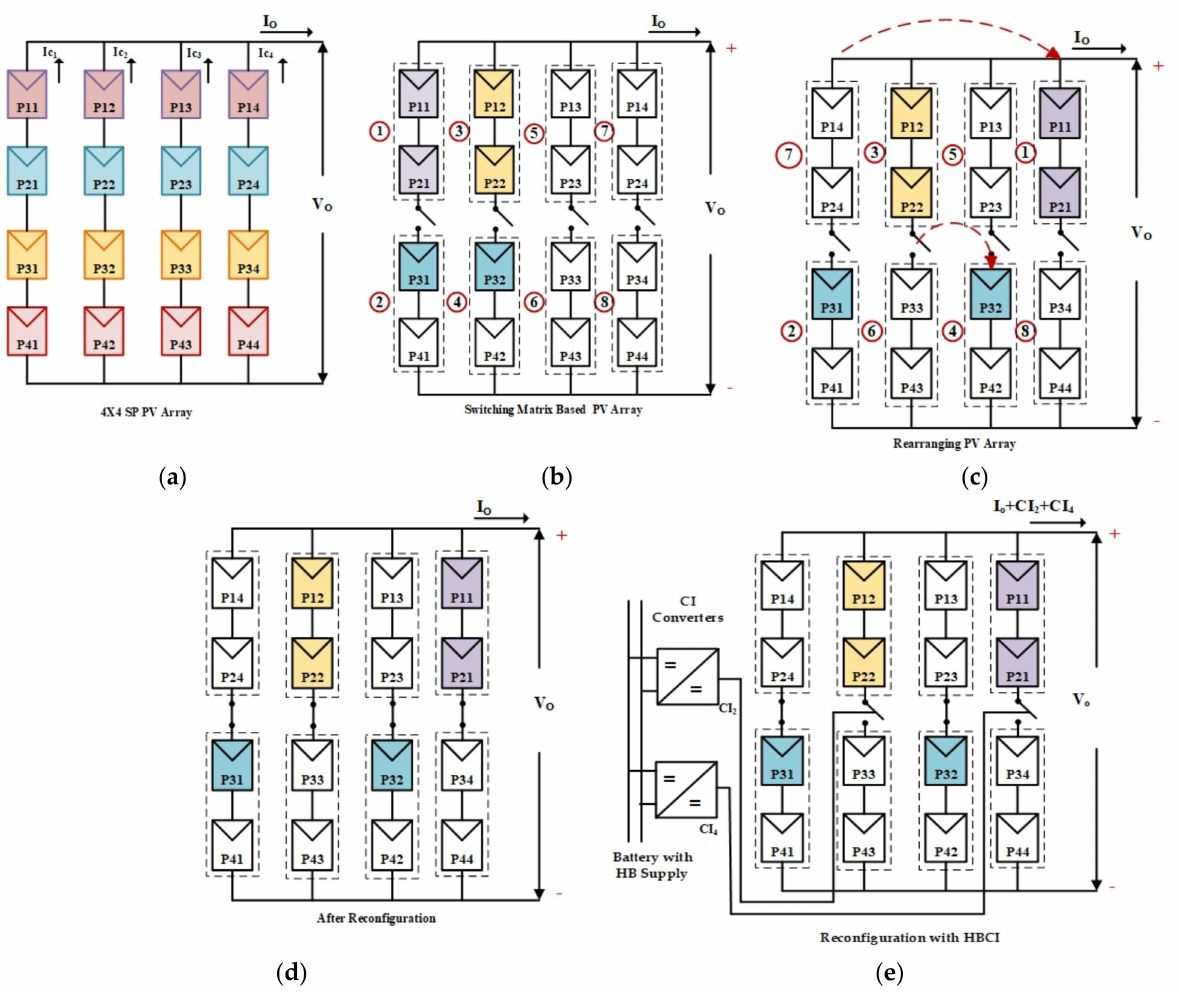
Figure 7. ( a ) The 4 × 4 SP PV array; ( b ) the switching matrix-based PV array; ( c ) rearranging the PV array; ( d ) after reconfiguration; ( e ) reconfiguration with Half-Bridge Current Injection